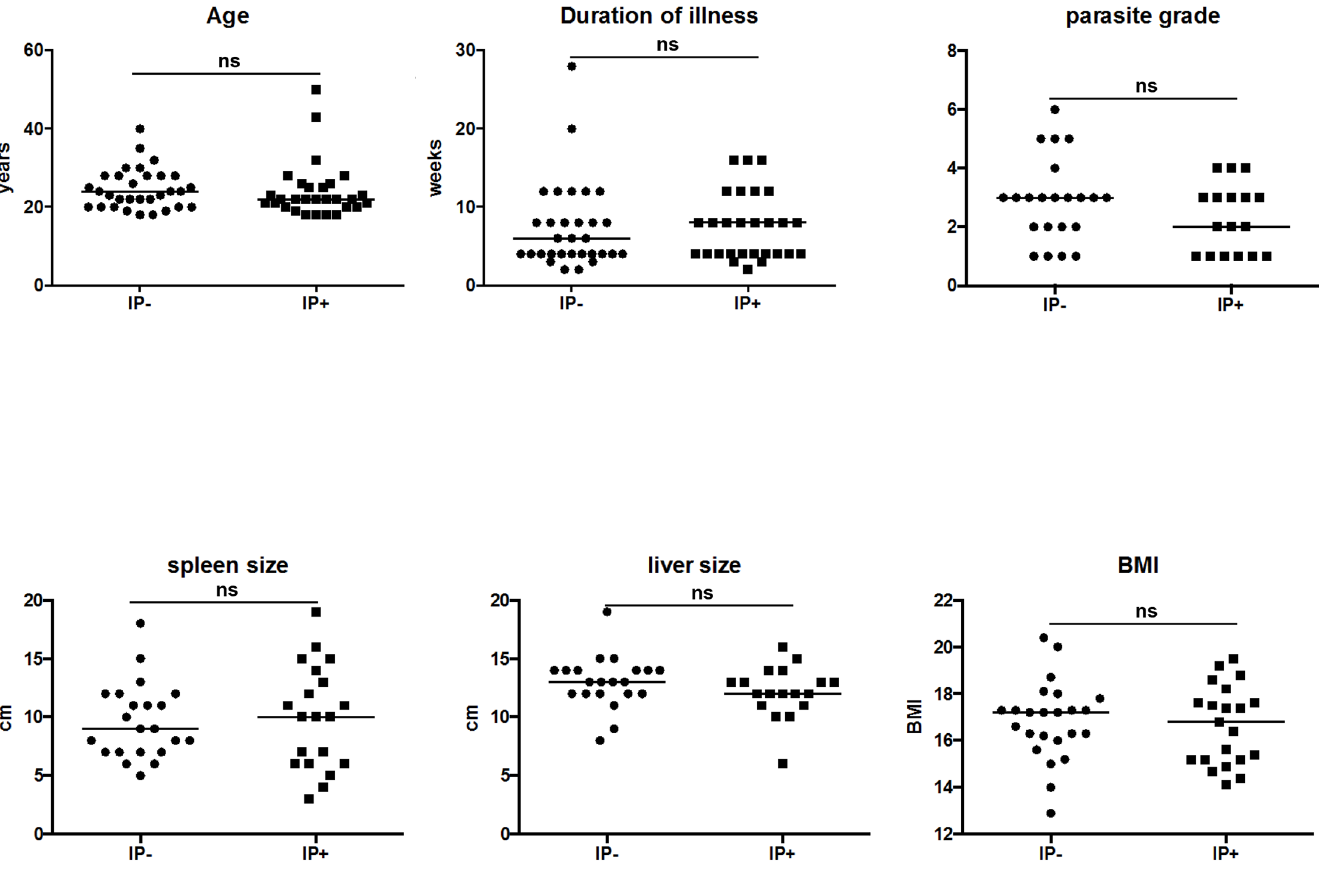
Fig 1. The age, duration of illness (defined as the number of weeks since the patients noticed symptoms associated with visceral leishmaniasis, such as fever, and/or enlarged abdomen (as a sign of enlarged spleen or liver), parasite grades, spleen and liver sizes and BMI was measuredas described in Materials and Method in VL patients without intestinal parasite co-infections (IP-) and in VL patients co-infected with intestinal parasites(IP+). Statistical significancewas established using a Mann-Whitney test, ns = not significant( p < 0.05).